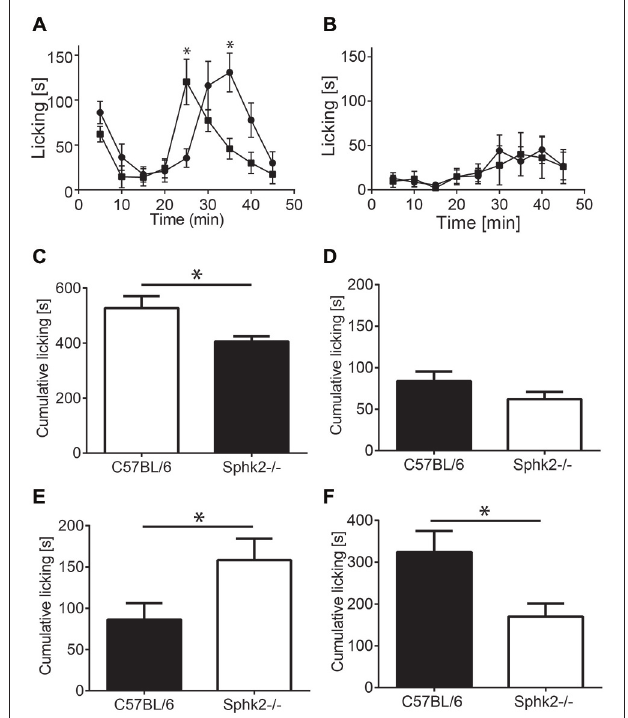
FIGURE 3 | Licking response to acute peripheral inflammation induced by formalin. (A) Time course of the response of C57BL/6 mice (black squares) and Sphk2 − / − mice (black circles) to injection of 2% formalin. Time points represent mean ± SEM response of eight animals during 5 min intervals. Asterisks indicate significantly greater time licking (* p < 0.05, two-way ANOVA, Bonferroni’s test). (B) Time course of the response of C57BL/6 mice (black squares) and Sphk2 − / − mice (black circles) to injection of 0.5% formalin. The response to injection of 0.5% formalin was not different between strains. (C–F) Cumulative paw licking time in intervals. Values represent mean ± SEM. (C) Overall time spent licking in response to 2% formalin (unpaired t -test, * p < 0.05). (D) Overall response to 0.5% formalin. (E) Time spent licking between 10–25 min (unpaired t -test, * p < 0.05). (F) Time spent licking between 25–45 min (unpaired t -test, * p <